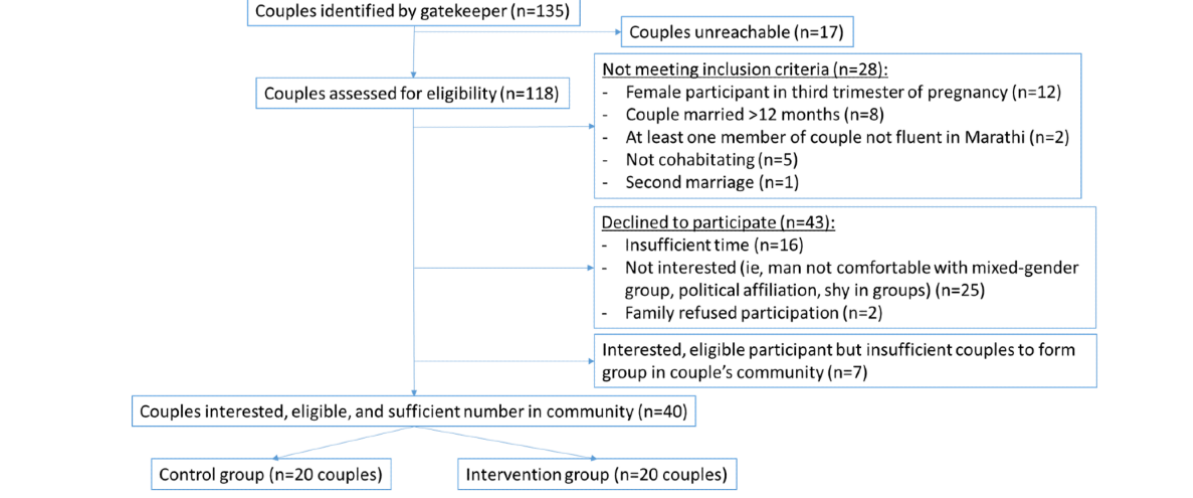
Figure 1. Recruitment and enrollment of participants into Ghya Bharari Ekatra intervention and control groups.